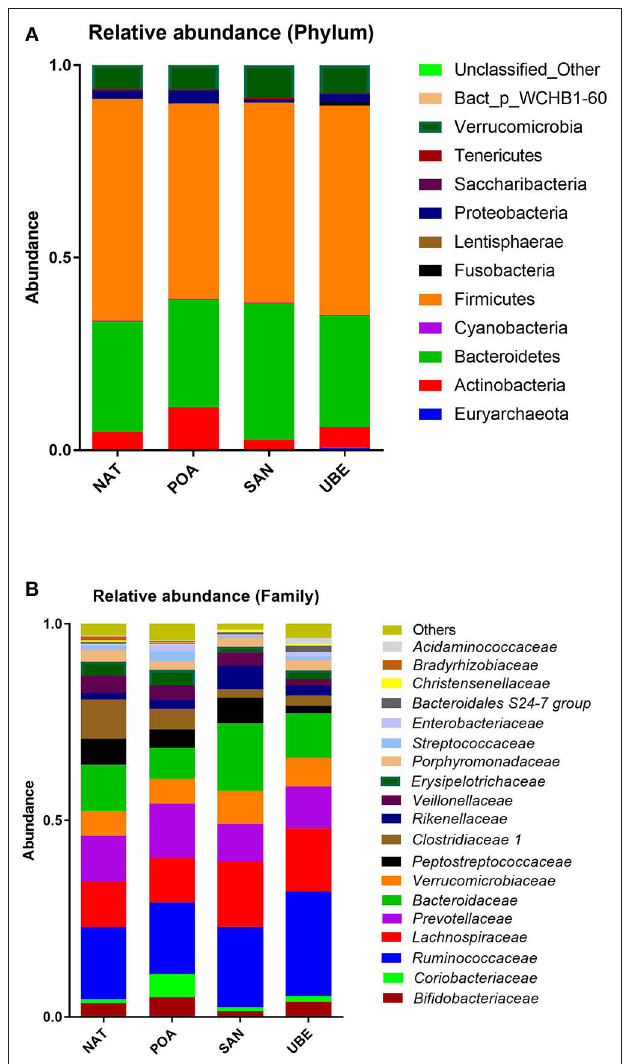
FIGURE 3 | Relative abundance at the (A) phylum and (B) family level shows dominance of taxa affiliated to the phyla Firmicutes and Bacteroidetes (shown in gray and light blue,